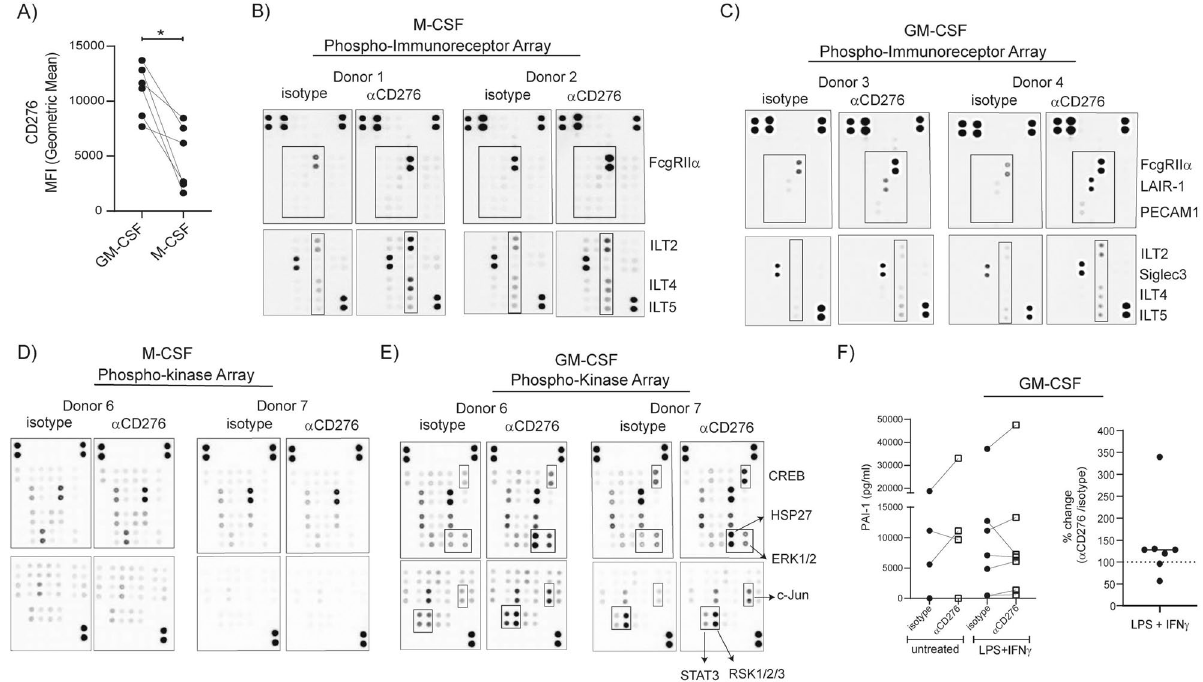
Figure 5. Targeting CD276 on macrophages with specific antibodies induces distinct immunoreceptor phosphorylation accompanied with kinase phosphorylation. ( A ) Monocytes were cultured either in GM-CSF or M-CSF supplemented medium for 7 days. CD276 expression on monocyte-derived macrophages (MDMs) was analyzed by flow cytometry and CD276 MFI values from six paired samples are summarized in the graph. ( B-E) After 7 days culture, MDMs were reseeded for Phospho-Immunoreceptor and Phospho-kinase array. After 3 h resting, MDMs were treated with αCD276 antibody or isotype for 10 min for Phospho-immunoreceptor array and 30 min for Phospho-Kinase array. Cell lysates were processed for phosphorylation signatures. In total macrophages from 4–5 donors were tested. Two representative donors are shown for Phospho-Immunoreceptor arrays: ( B) M-CSF MDMs and ( C) GM-CSF MDMs. Two representative and matching donors are shown for Phospho-Kinase arrays: ( D) M-CSF MDMs and ( E) GM-CSF MDMs. ( F) MDMs (GM-CSF) were left untreated or treated with LPS + IFNγ in the presence of αCD276 antibody or isotype control for 24 h. The graphs summarize the concentration of PAI-1 in the supernatants. Each dot represents one